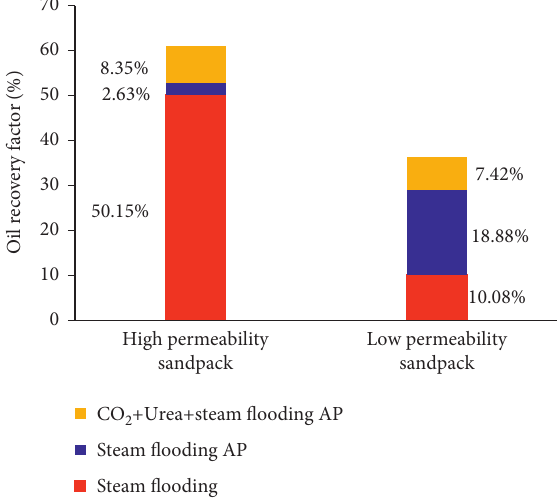
Figure 7: Comparison of production performance before and after plugging with different-permeability sand pack models. AP—after